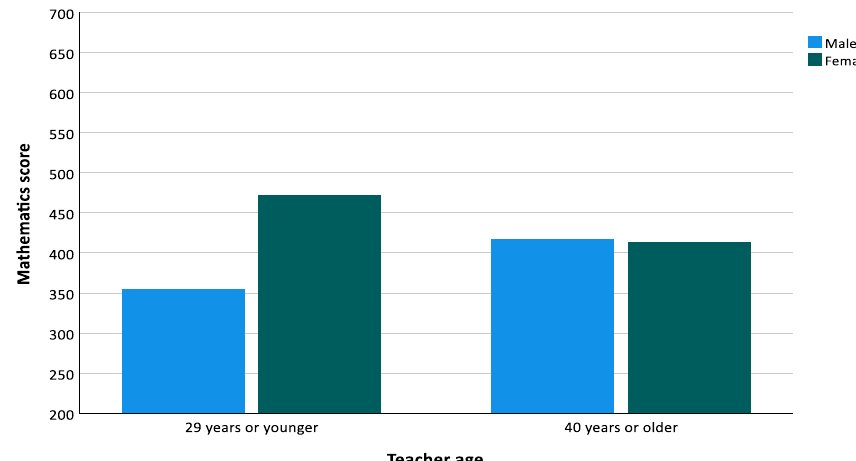
Fig. 4 Interaction between gender and teacher age on mathematics achievement, grade 4. The plot presents the predicted values from step 7 of the mathematics model for grade 4 (Table 10). Only the reference category and the category for which a statistically significant interaction with gender was found are